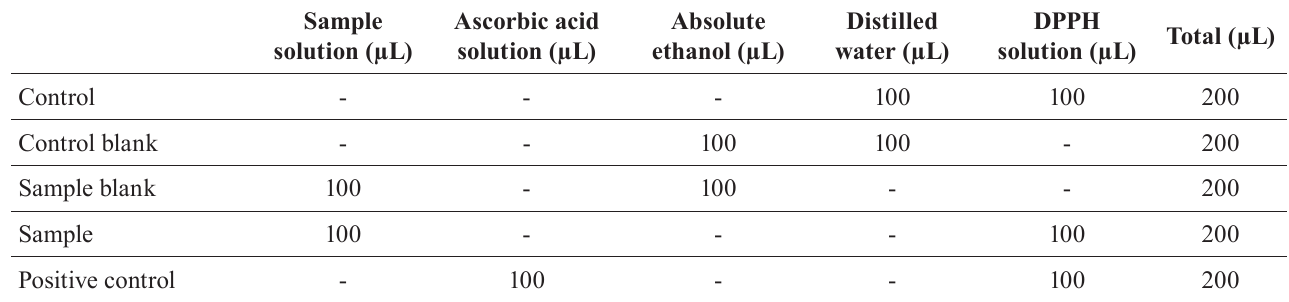
TABLE I - C ompositions of mixtures in 96-well